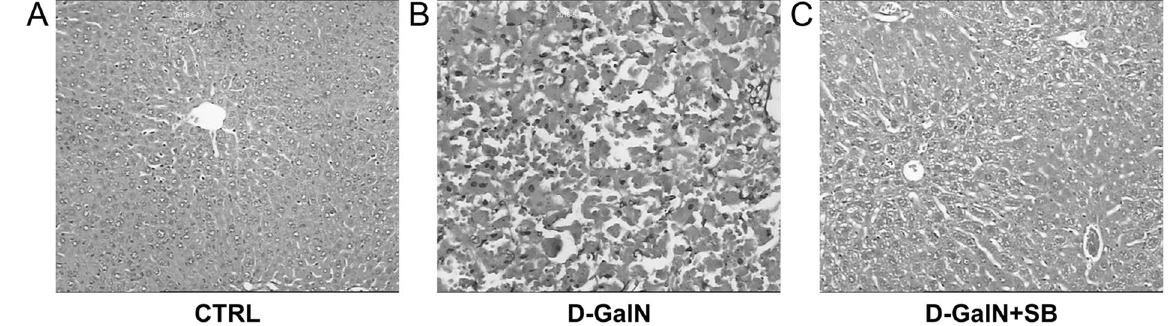
Figure 2. Histological analysis of liver sections. ( A ) Histology of the CTRL group with normal liver architecture. ( B ) The D-GalN group exhibited severe hemorrhage, inflammation, and necrosis of hepatocytes. ( C ) Hepatic injury was attenuated in the D-GalN + SB group.